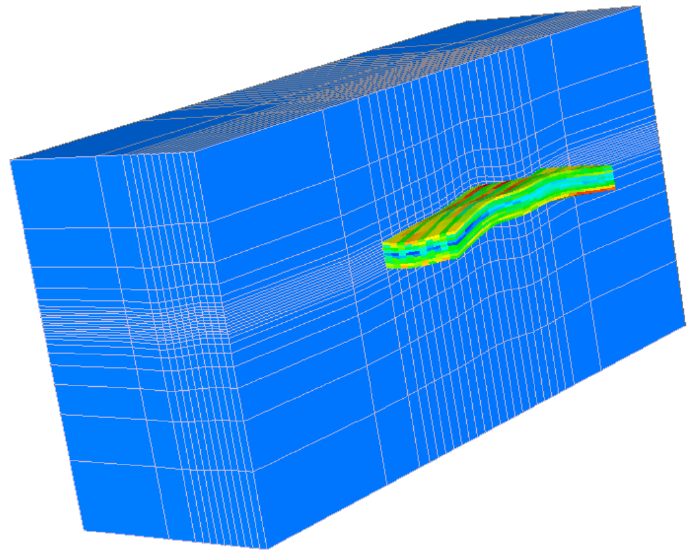
Figure 28. Conforming mesh for mechanics and the pay-zone’s